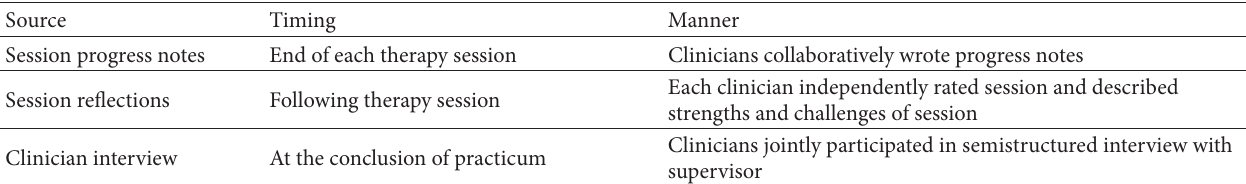
Table 3: Sources for clinicians’